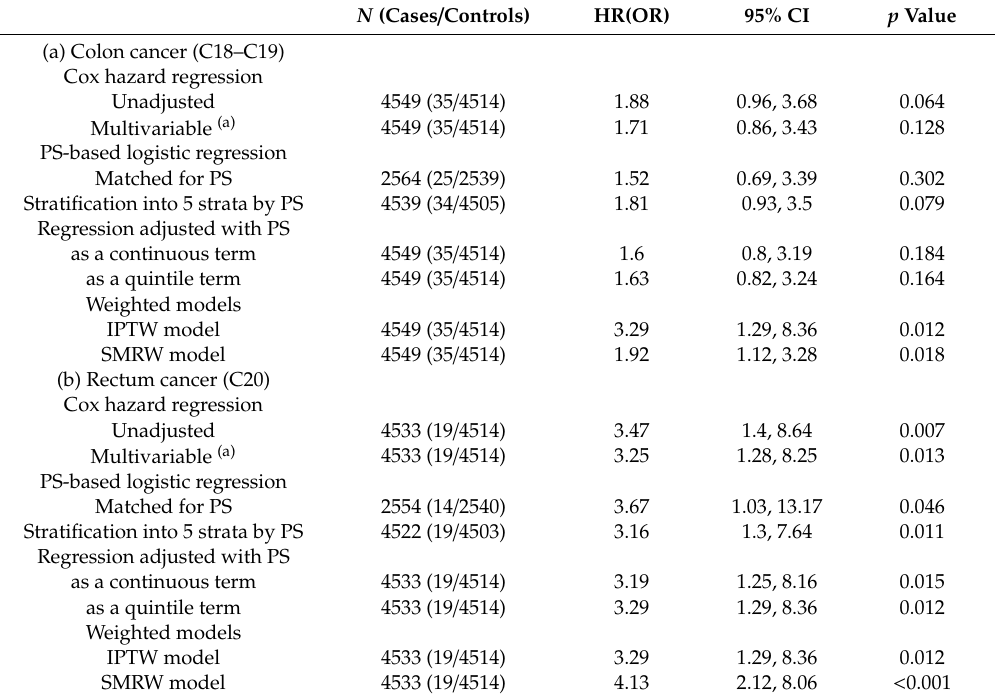
Table 3. Associations between metabolic syndrome and the incidence of (a) colon cancer and (b) rectum cancer in women. N (Cases / Controls) HR(OR) 95% CI p